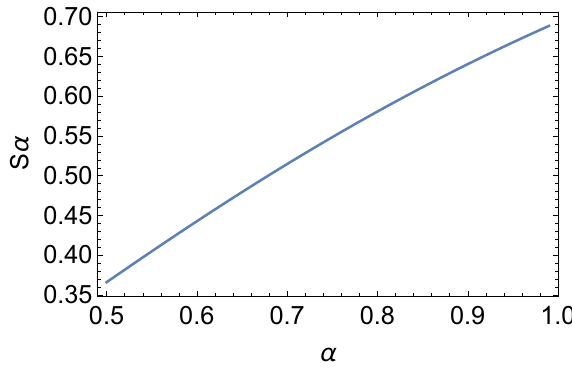
Figure 5 . S (cid:11) in the mR (cid:29) 1 limit, for di(cid:11)erent values of (cid:11)